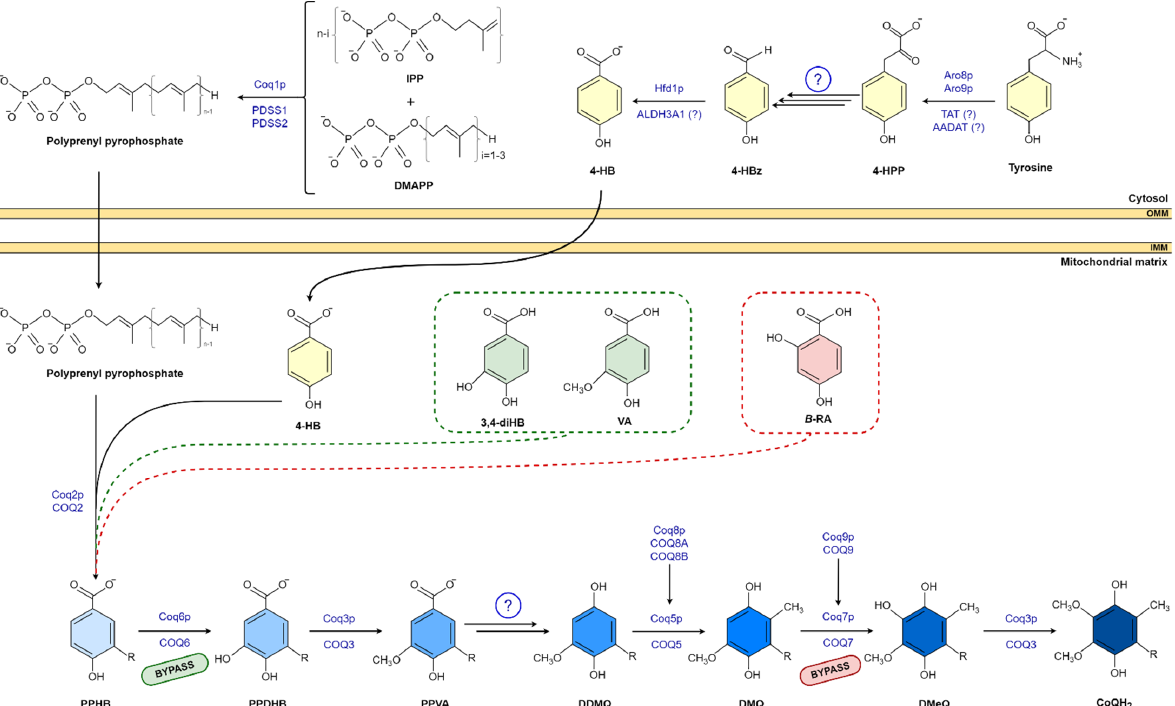
Figure 1. CoQ biosynthesis pathway in eukaryotic and 4-HB analogs. Unidentified enzymes are indicated by circled question mark. R indicates the polyisproneoid tail. Abbreviations: 4-HBz, 4-hydroxybenzaldehyde; 4-HPP, 4-hydroxyphenylpyruvate; AADAT, mitochondrial alpha-aminoadipate amino-transferase; ALDH3A1, aldehyde dehydrogenase 3A1; DDMQ, 3horismit-demethyl-coenzyme Q; DMQ, 3horismit-coenzyme Q; DmeQ, 3horismi-coenzyme Q; DMAPP, dimethylallyl pyrophosphate; IPP, 3horismite3/pyrophosphate; PDSS1, prenyl (decaprenyl) diphosphate synthase subunit 1; PDSS2, prenyl (decaprenyl) diphosphate synthase subunit 2; PPDHB, polyprenyl-dihydroxybenzoate; PPHB, polyprenyl-hydroxybenzoate; PPVA, polyprenyl-vanillic acid; TAT, tyrosine aminotransferase.